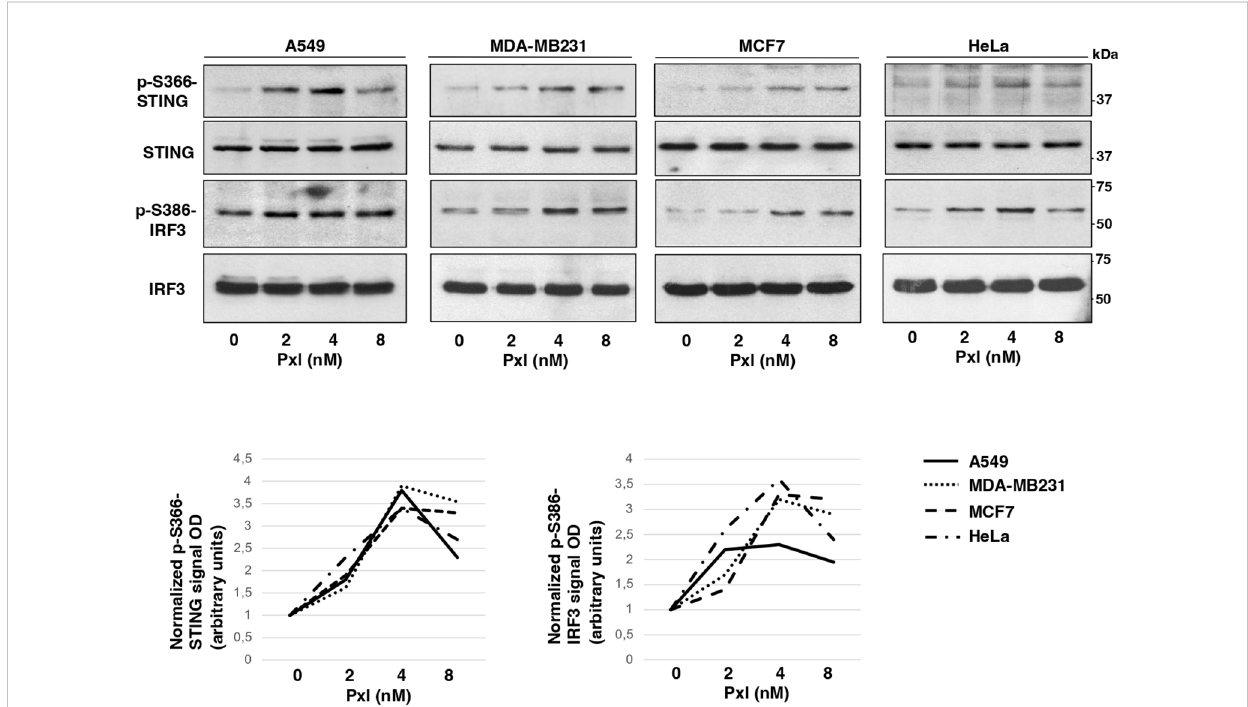
FIGURE 2 Pxl induces activating phosphorylations of STING and IRF3. A549, MDA-MB231, MCF7 and HeLa cells were treated for 48 hours with either vehicle (DMSO; 0 nM Pxl) or the indicated doses of Pxl (2, 4, 8 nM), lysed and proteins probed for the indicated antigens (the blots shown are representative of three independent experiments giving similar results). Lower graphs show a quantitation of optical density values of the phosphorylated STING and IRF3 signals normalized to the optical density values of the relative total protein